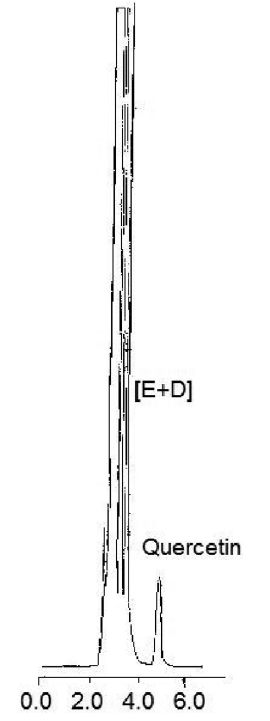
FIGURE 1 – Chromatogram of [E+D] homogenates compared to the profile of a 5 m g/mL quercetin solution. Chromatographic conditions: C18 Hypersyl BDS-CPS ciano (5 m m), 250 x 4.6 mm column - attached to a pre column, mobile phase: methanol: water (60:40 v/v) containing 2% acetic acid, 1 mL/ min. Detection at 254